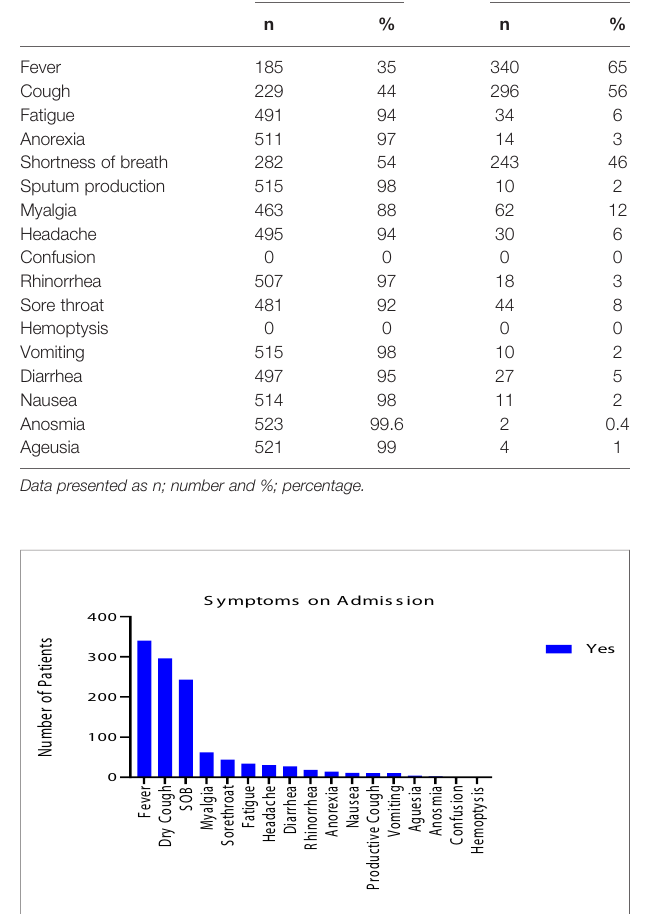
TABLE 2 | Comorbidities of 525 symptomatic COVID-19 patients. Comorbidities No